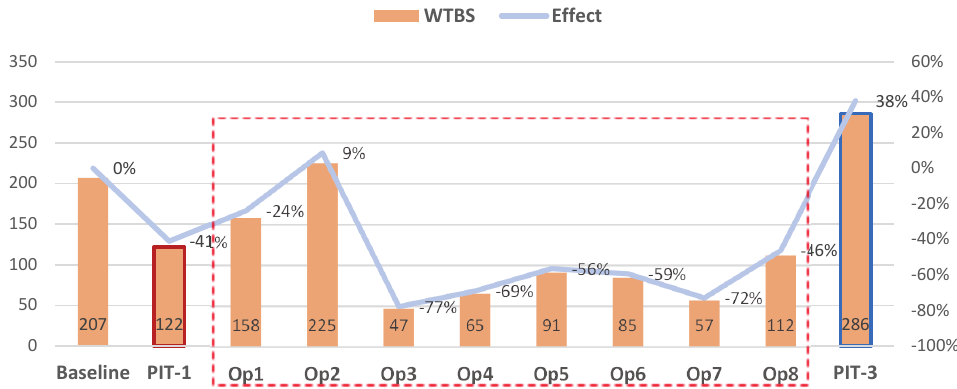
Fig. 11 . Effects of allocating a PIT during different hours of a day on patient average waiting time in comparison with the baseline measure (24hrs vs 8hrs in busy time vs non-busy